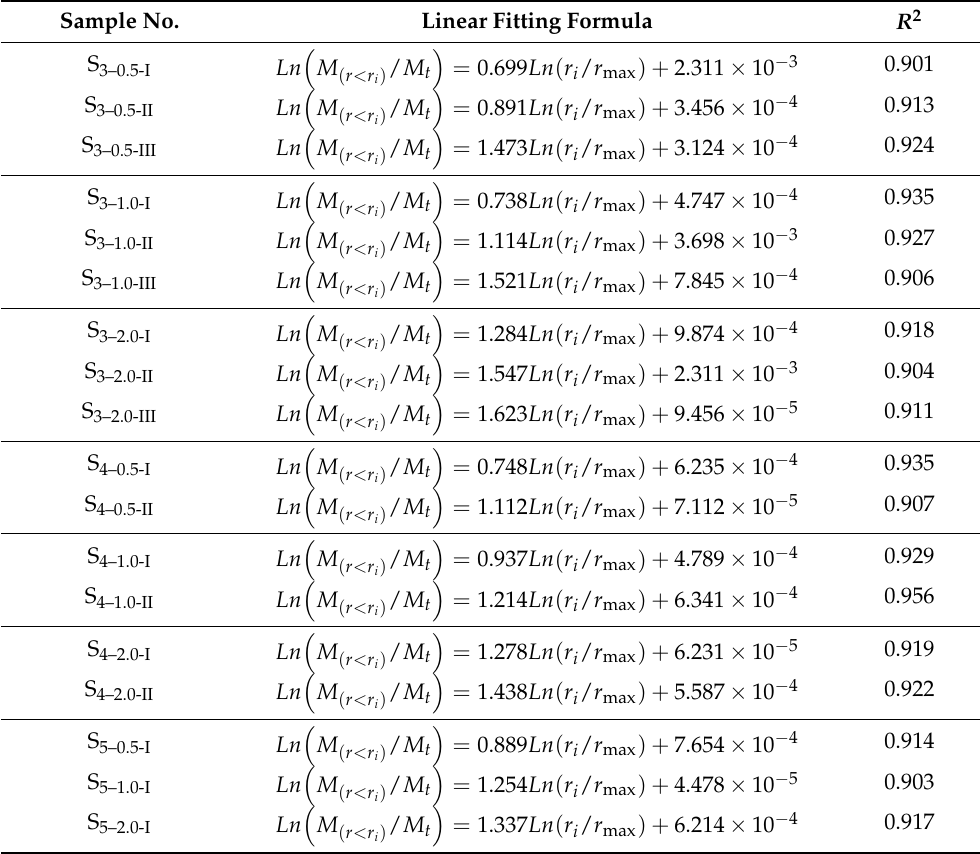
series samples. 5